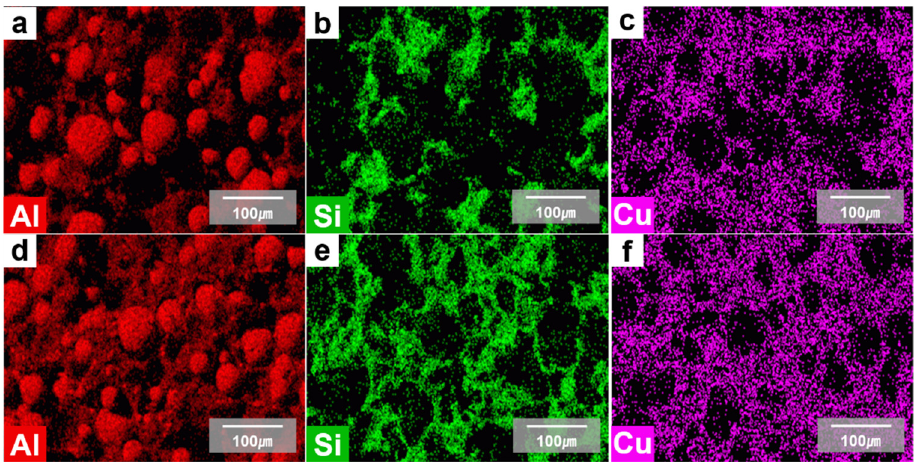
Figure 9. EDS mapping of thermal pads using aluminum oxide and copper powder of ( a – c ) type B- Cu 10 and ( d – f ) type E-Cu 10. Al, Si, and Cu are represented with red, green, and purple colors,